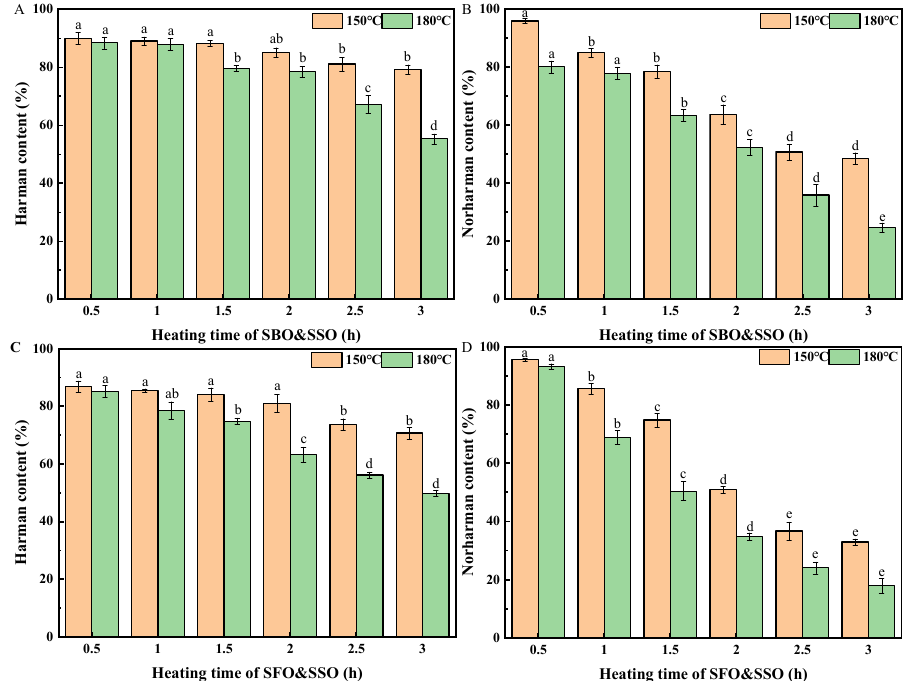
Figure 3. The content of harman in soybean oil blend (SBO&SSO) ( A ), the content of norharman in soybean oil blend (SBO&SSO) ( B ), the content of harman in sunflower seed oil blend (SFO&SSO) ( C ), the content of norharman in sunflower seed oil blend (SFO&SSO) ( D ). Different superscript letters indicate a significant difference at p -value < 0.05.